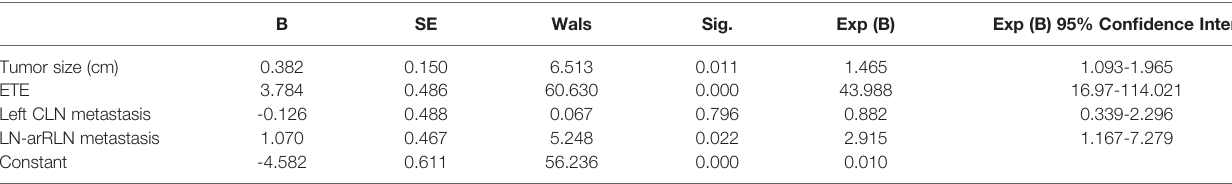
TABLE 8 | Multivariate analysis of predictor for LN-prRLN in cN0 PTC.